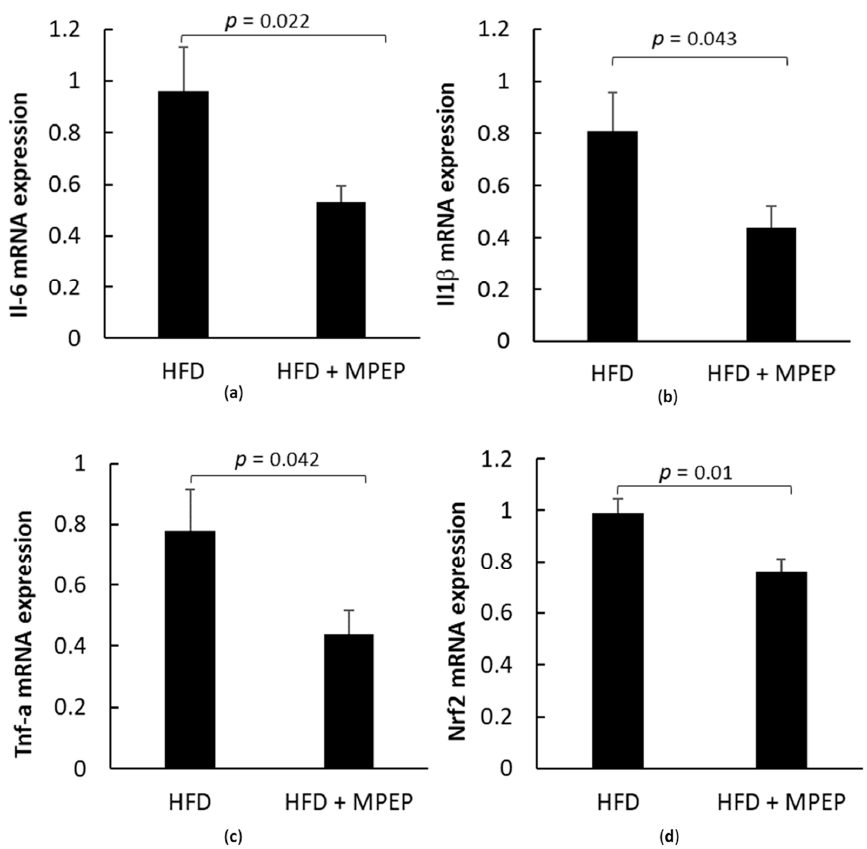
Figure 10. Inflammation and oxidative stress markers in obese mice. ( a ) Il-6 mRNA expression in liver from obese mice after 7 weeks of HFD administration, treated with MPEP 20 mg/Kg or vehicle; ( b ) Il1 β mRNA expression in liver from obese mice after 7 weeks of HFD ad-ministration, treated with MPEP 20 mg/Kg or vehicle; ( c ) Tnf- α mRNA expression in liver from obese mice after 7 weeks of HFD ad-ministration, treated with MPEP 20 mg/Kg or vehicle; ( d ) Nrf2 mRNA expression in liver from obese mice after 7 weeks of HFD ad-ministration, treated with MPEP 20 mg/Kg or vehicle. Results are mean ± SE of 6 individual determinations.